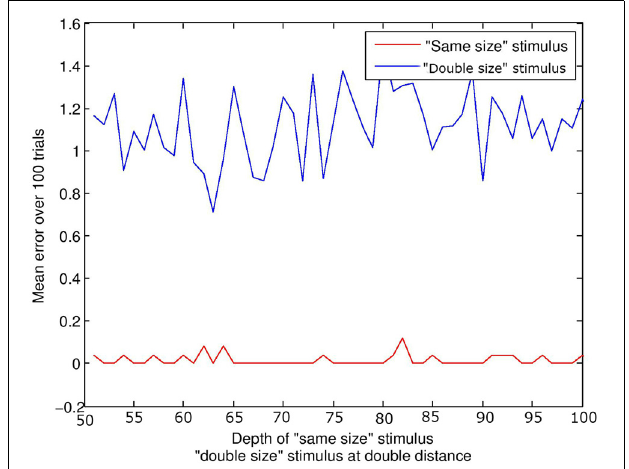
FIGURE 5 | Size constancy over depth. The lines represents the error at the end of the trial. The red line represents the “same size” condition, and the blue line the “double size” condition. For a given depth d of the “same size” stimulus, the “double size” stimulus was at twice the distance 2 d . Regardless of depth, the subject always finds and aligns with the “same size” stimulus, and ignores the “double size”